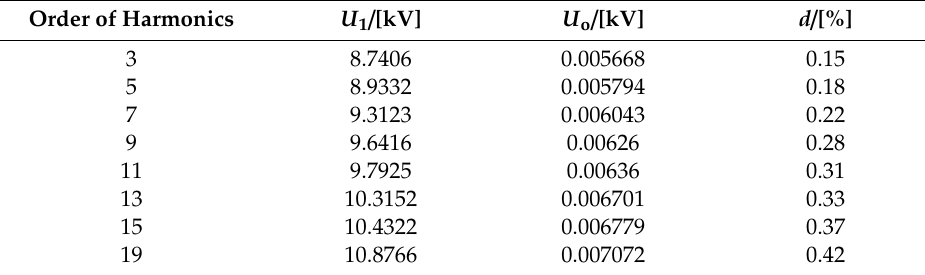
Table 2. Relationship between harmonic and voltage error.